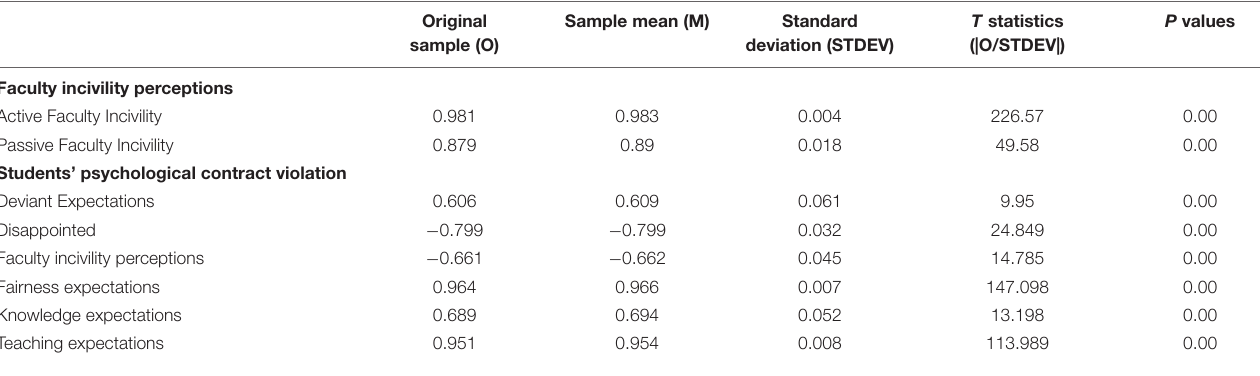
TABLE 3 | Mean, STDEV, T -values, P